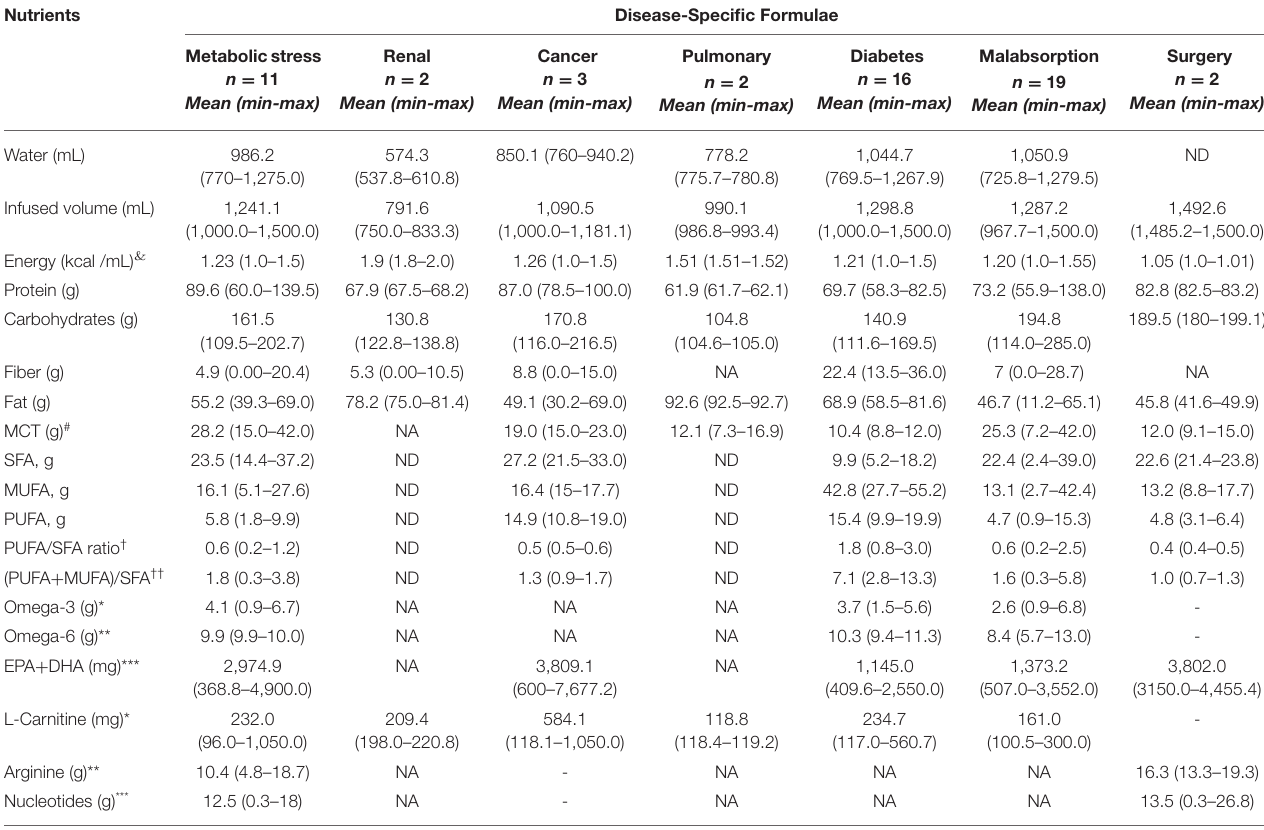
TABLE 2 | Macronutrient distribution, fatty acid profile, fat quality ratios, and some immunomodulatory nutrients in disease-specific formulae a . Nutrients Disease-Specific